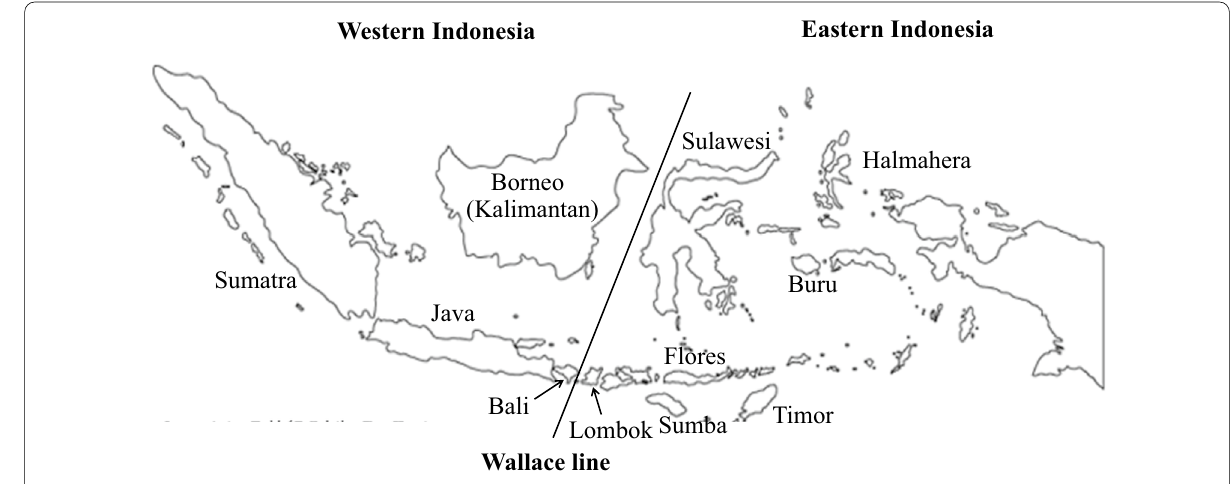
Fig. 1 The Indonesian archipelago separated into western and eastern parts by the Wallace line